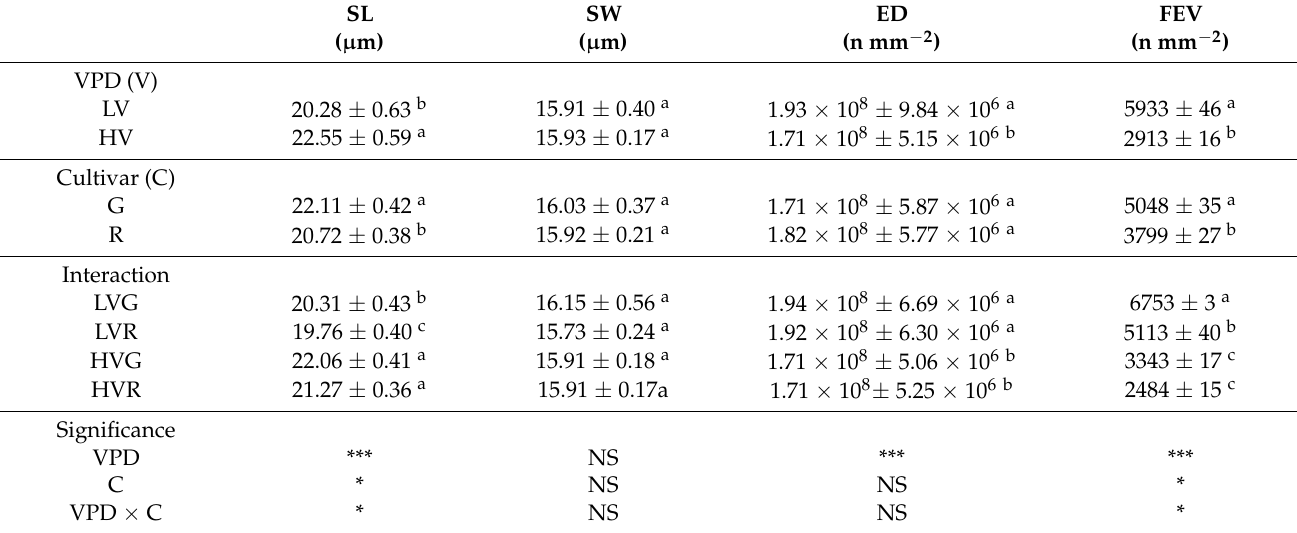
Table 2. Stomata and vein traits in terms of stomatal length (SL), stomatal width (SW), epidermal cell density (ED) and free vein endings (FEV) of green (G) and red (R) Salanova plants grown under low (LV) and high (HV) VPD, with no differences within the leaf parts. All data are reported as mean ± se of 9 replicates. Different letters correspond to statistically significant differences according to Tukey test ( p <